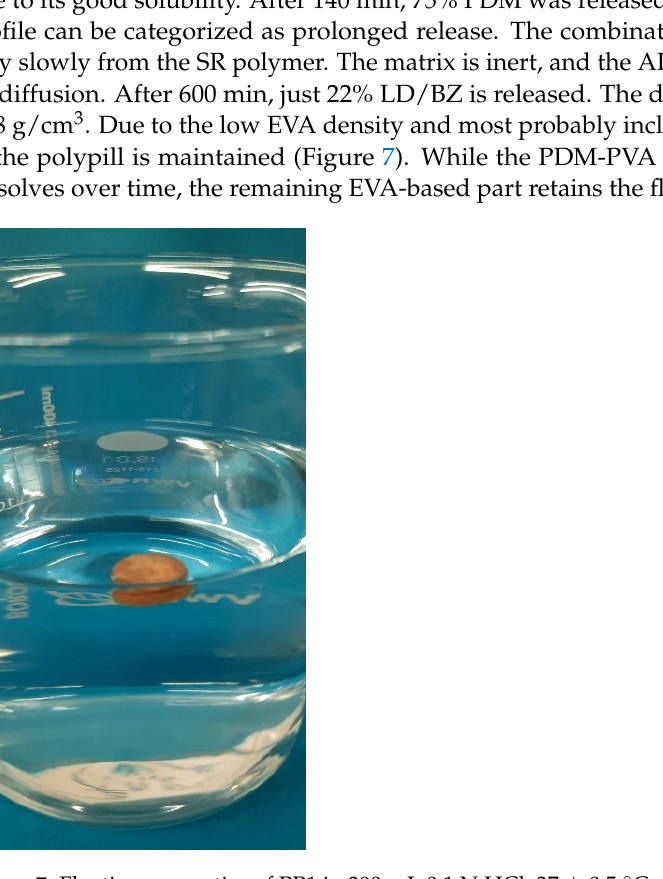
Table 8. Structure and release properties of